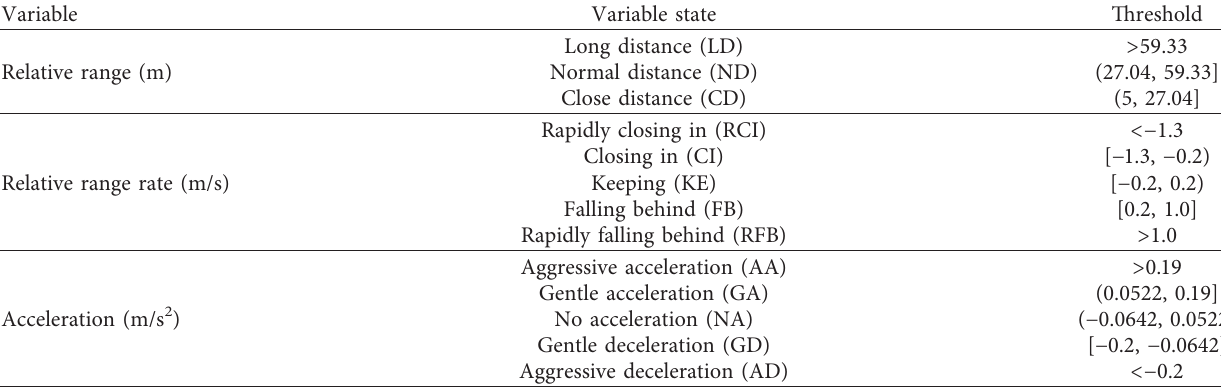
Table 1: Variable segmentation of feature